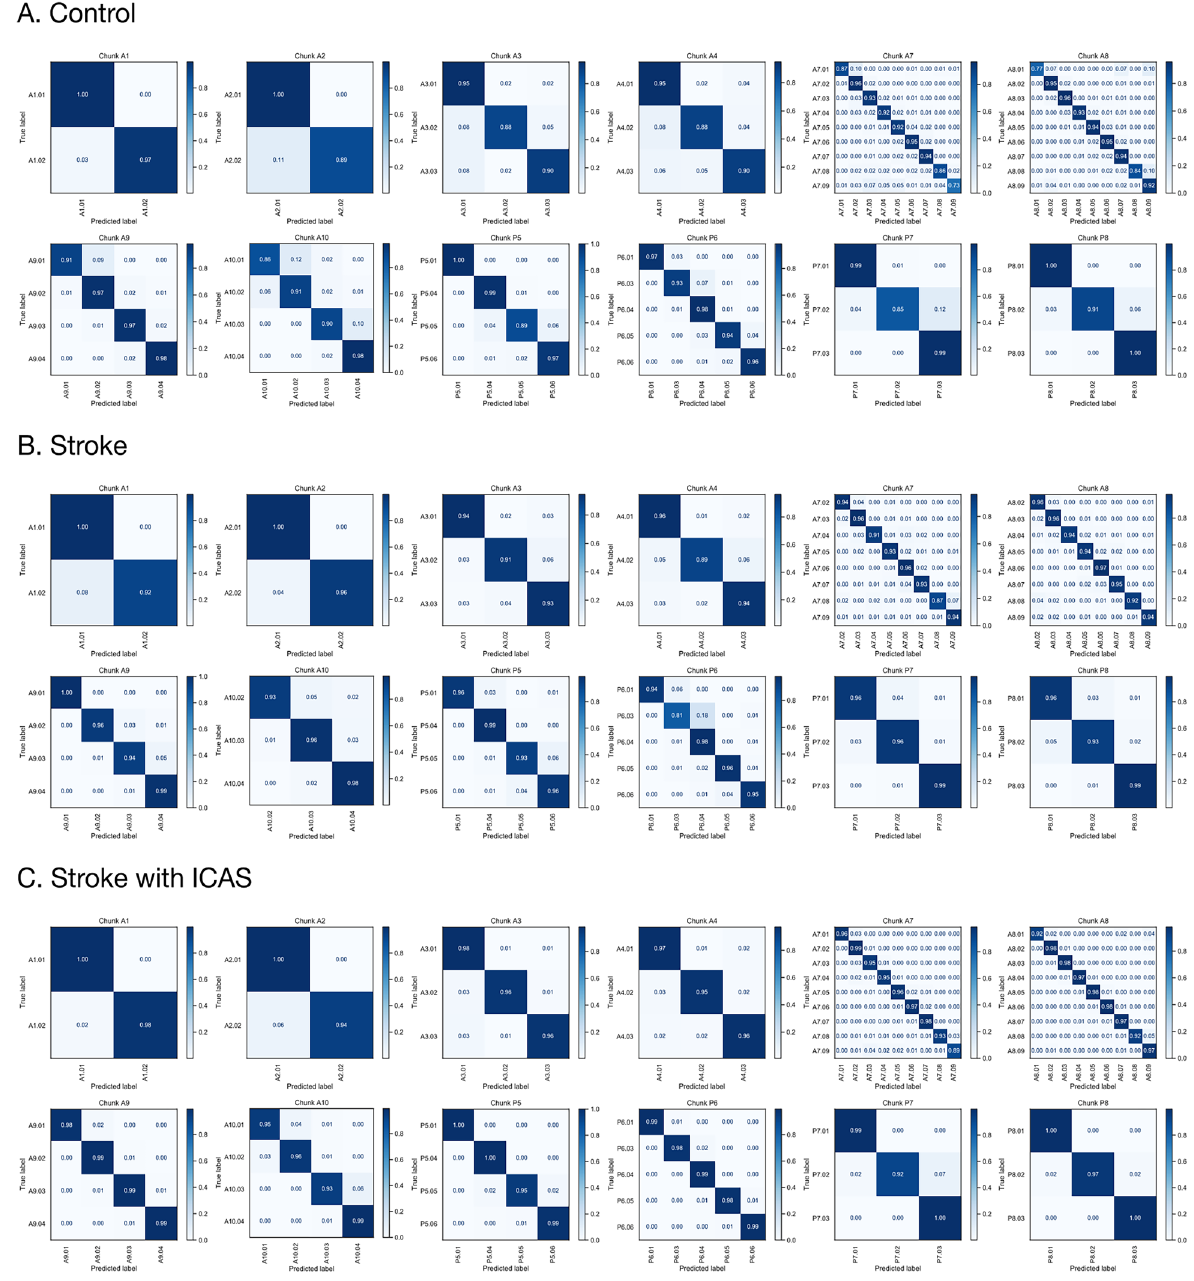
Figure 3. Prediction performance profiles of 62 major arterial branches in control, stroke-with-ICAS, and stroke group cohorts. The right and left posterior VA, BA, and ACOA chunks only include one significant type of arterial segment. The ( A ) control, ( B ) stroke, and ( C ) stroke-with-ICAS groups showed significant arterial segment classification capacity in the A0–A10 and P0–P8